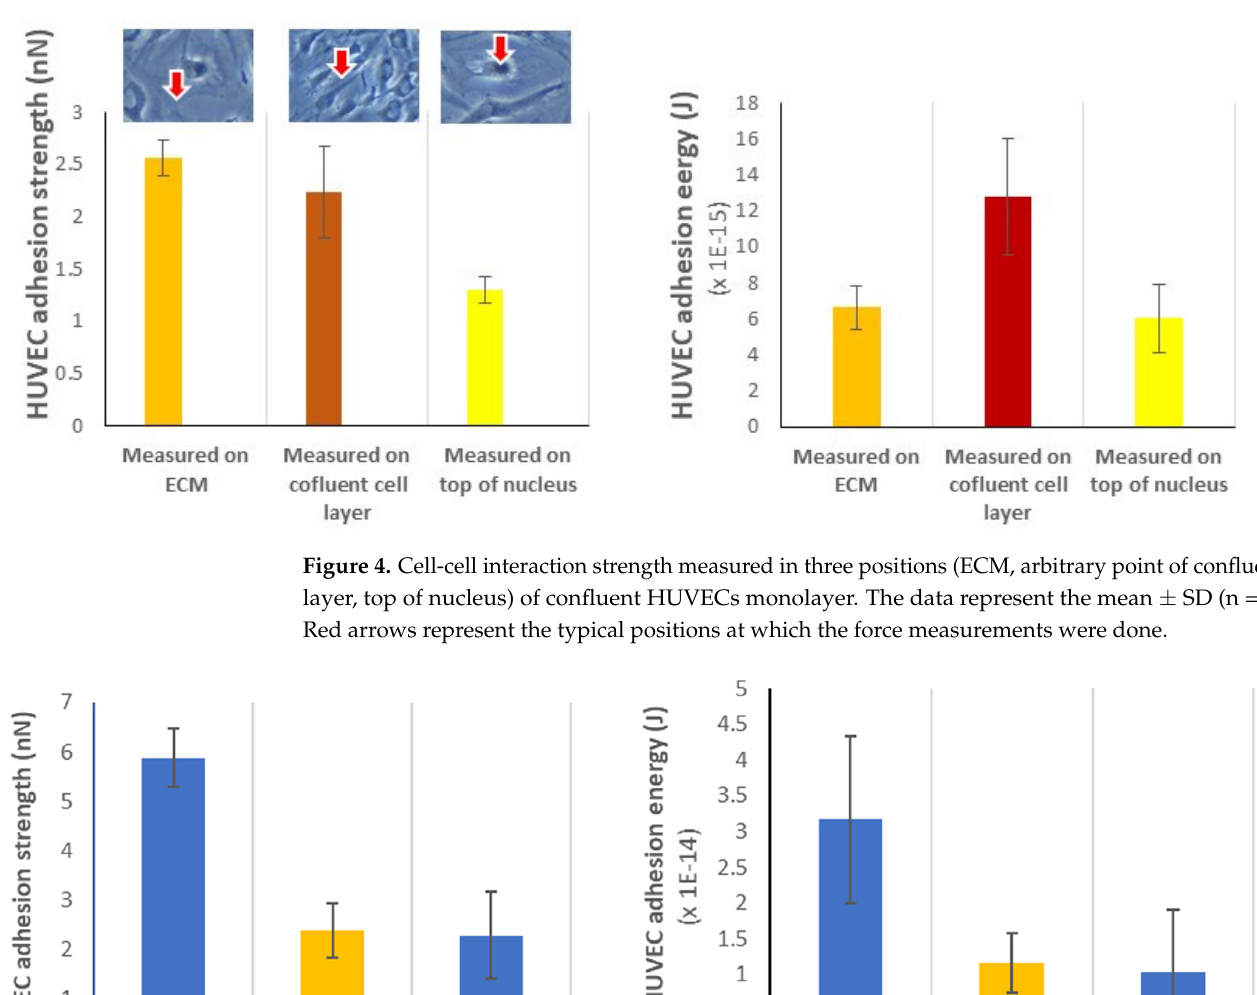
Figure 4. Cell-cell interaction strength measured in three positions (ECM, arbitrary point of conflu- ent layer, top of nucleus) of confluent HUVECs monolayer. The data represent the mean ± SD (n = 4). Red arrows represent the typical positions at which the force measurements were done.